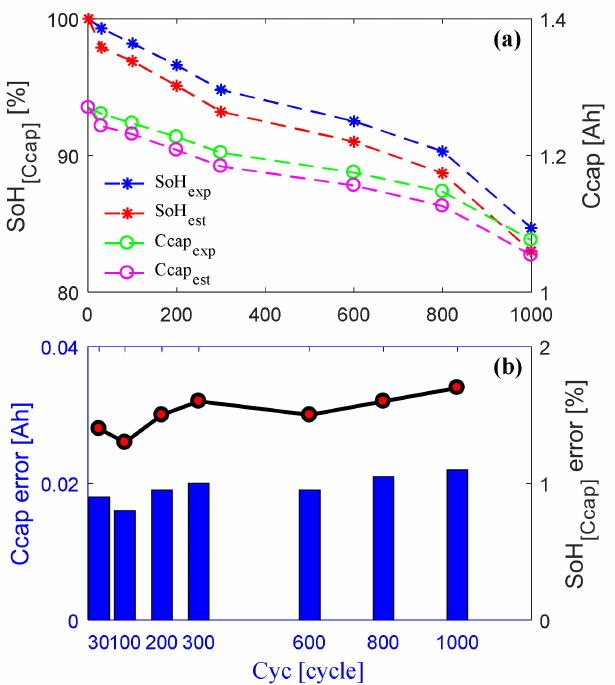
Figure 10. ( a ) Capacity and SoH [Ccap] estimation results; ( b ) capacity error and SoH [Ccap] error under different cycle